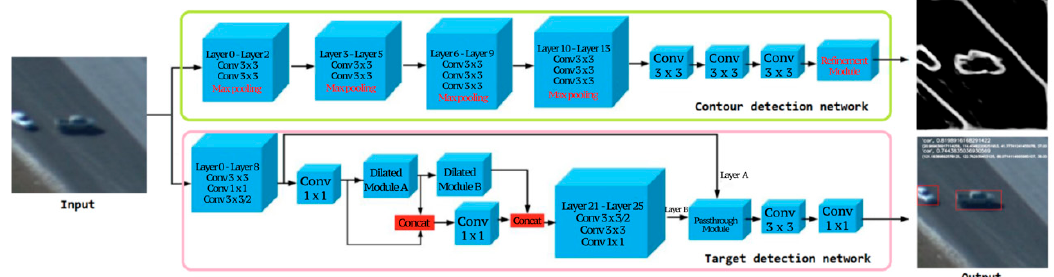
Figure 4. Framework of template-update network.